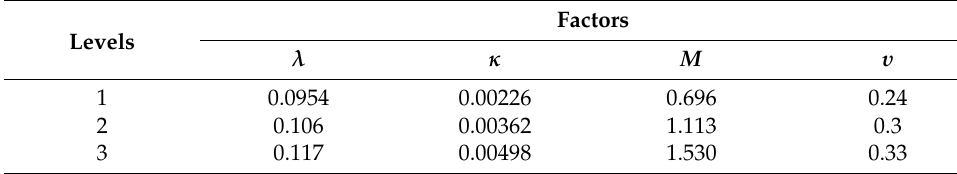
Table 4. Four factors and the corresponding levels in the